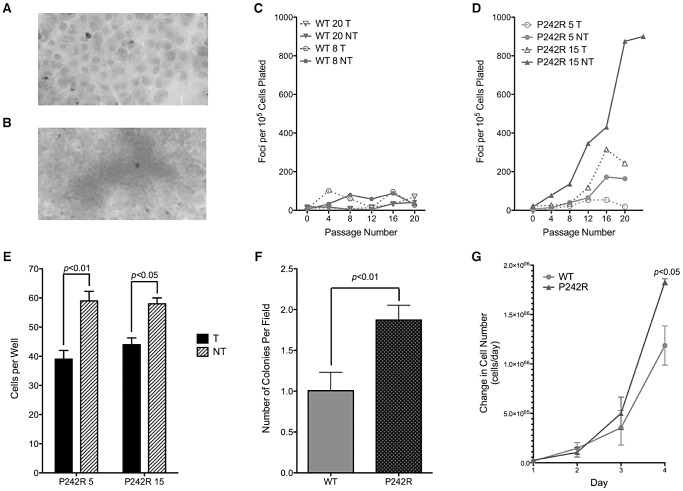
Expression of P242R induces cellular transformation.A. Representative image of crystal violet stained untransformed cells. Note the clear monolayer of cell growth. B. Representative image of a focus. Note the accumulation of cells as marked by dark staining. C–D. Focus formation assay with two clonal cell lines either inducing (NT, solid line) or not inducing (T, dashed line) exogenous (C.) WT or (D.) P242R Pol β. Mean foci per 105 cells plated (± standard deviation of plating replicates) plotted against passage number. E. Anchorage independent growth assay with P242R clonal cell lines from the focus formation assay. Cells per field (± standard error) are plotted on the Y-axis. F. Anchorage independent growth assay with MCF10A pools expressing WT or P242R. The number of colonies per field are plotted on the Y-axis. G. WT or P242R MCF10A pools were plated in 5 dishes at a density of 25,000 or 50,000 cells per dish. Cells were trypsinized and counted each day. Data are plotted as the mean ± SEM of the change in cell number (n = 3).